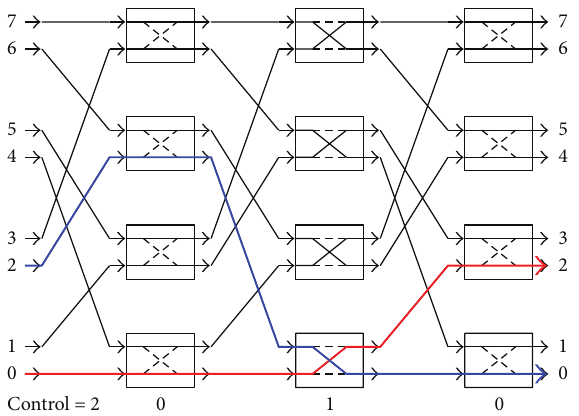
Figure 9: An 8-by-8 Omega network. We turn columns ON or OFF to rotate between different routing